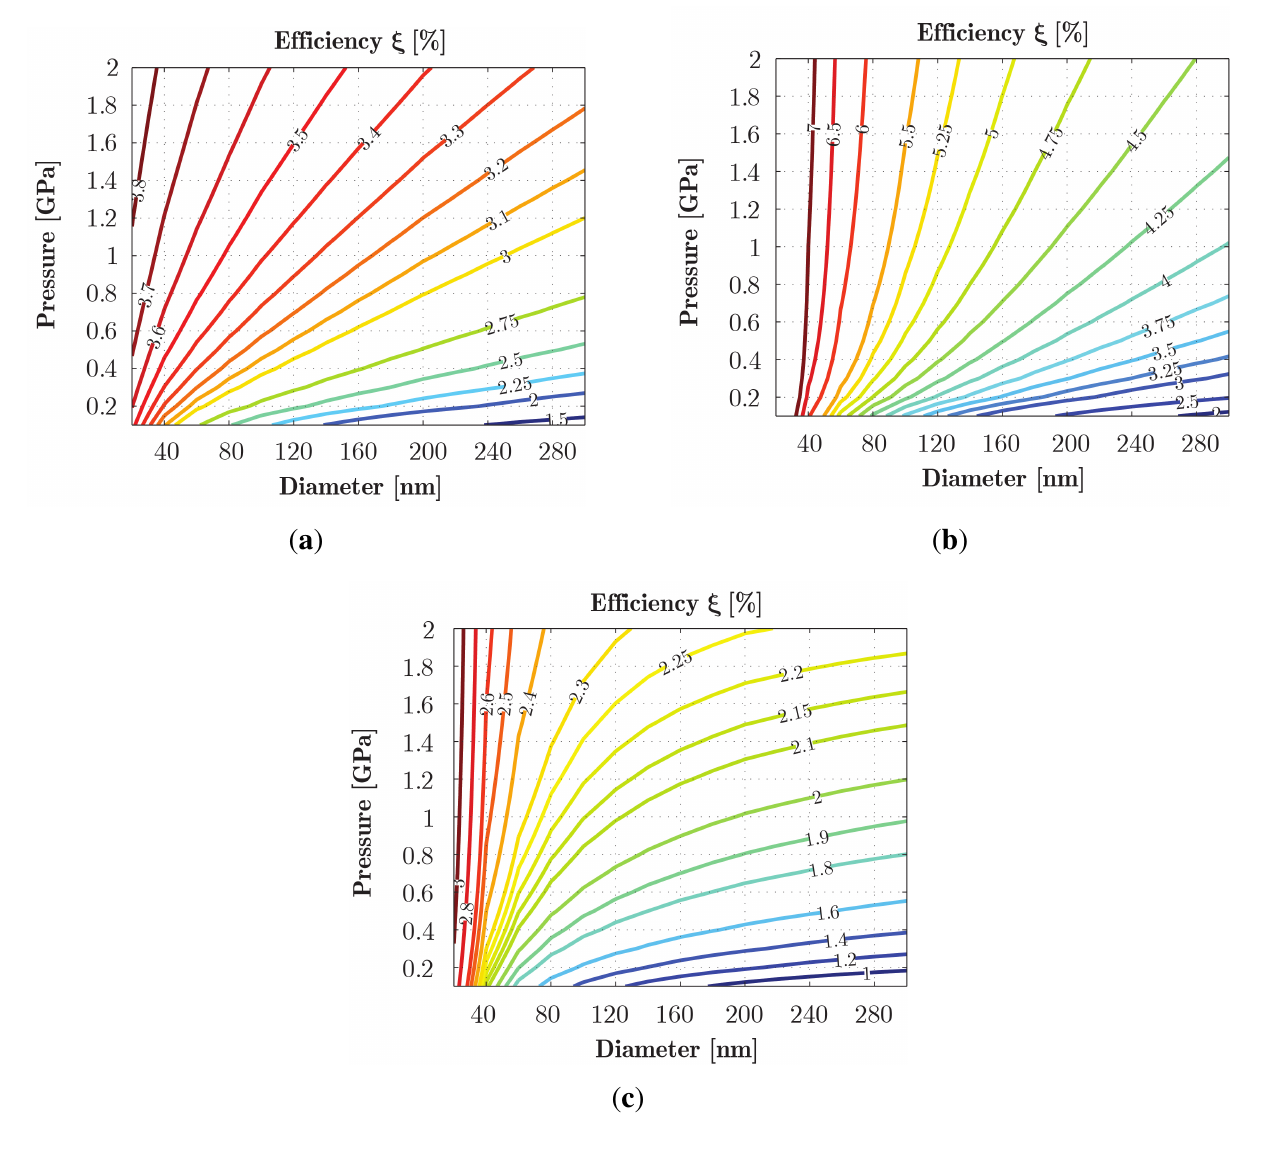
Figure 11. Simulation results comparing the efficiency ξ from bulk versus SE models over a D range of 20–300 nm and pressure p from 0.1 GPa up to 2 GPa, for conical NWs with aspect ratio k = 5 : (a) bulk model; (b) scale-effect on the piezoelectric constant; (c) scale-effect on the piezoelectric constant and the Young’s